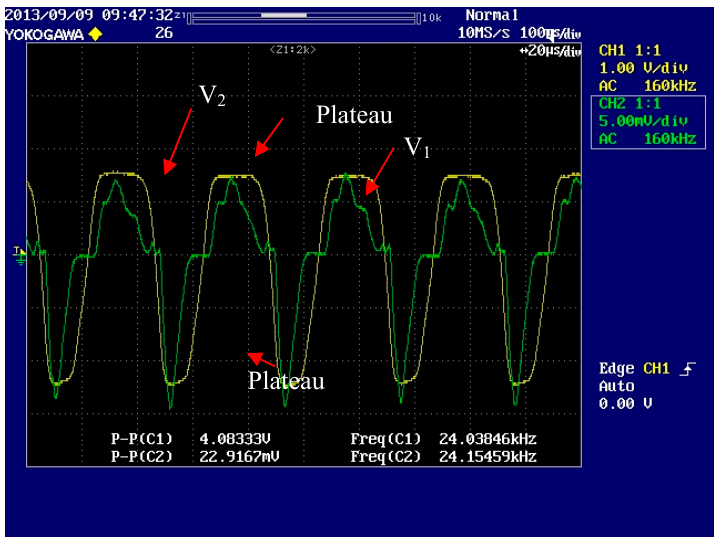
Figure 11. Output signal of the harvester.